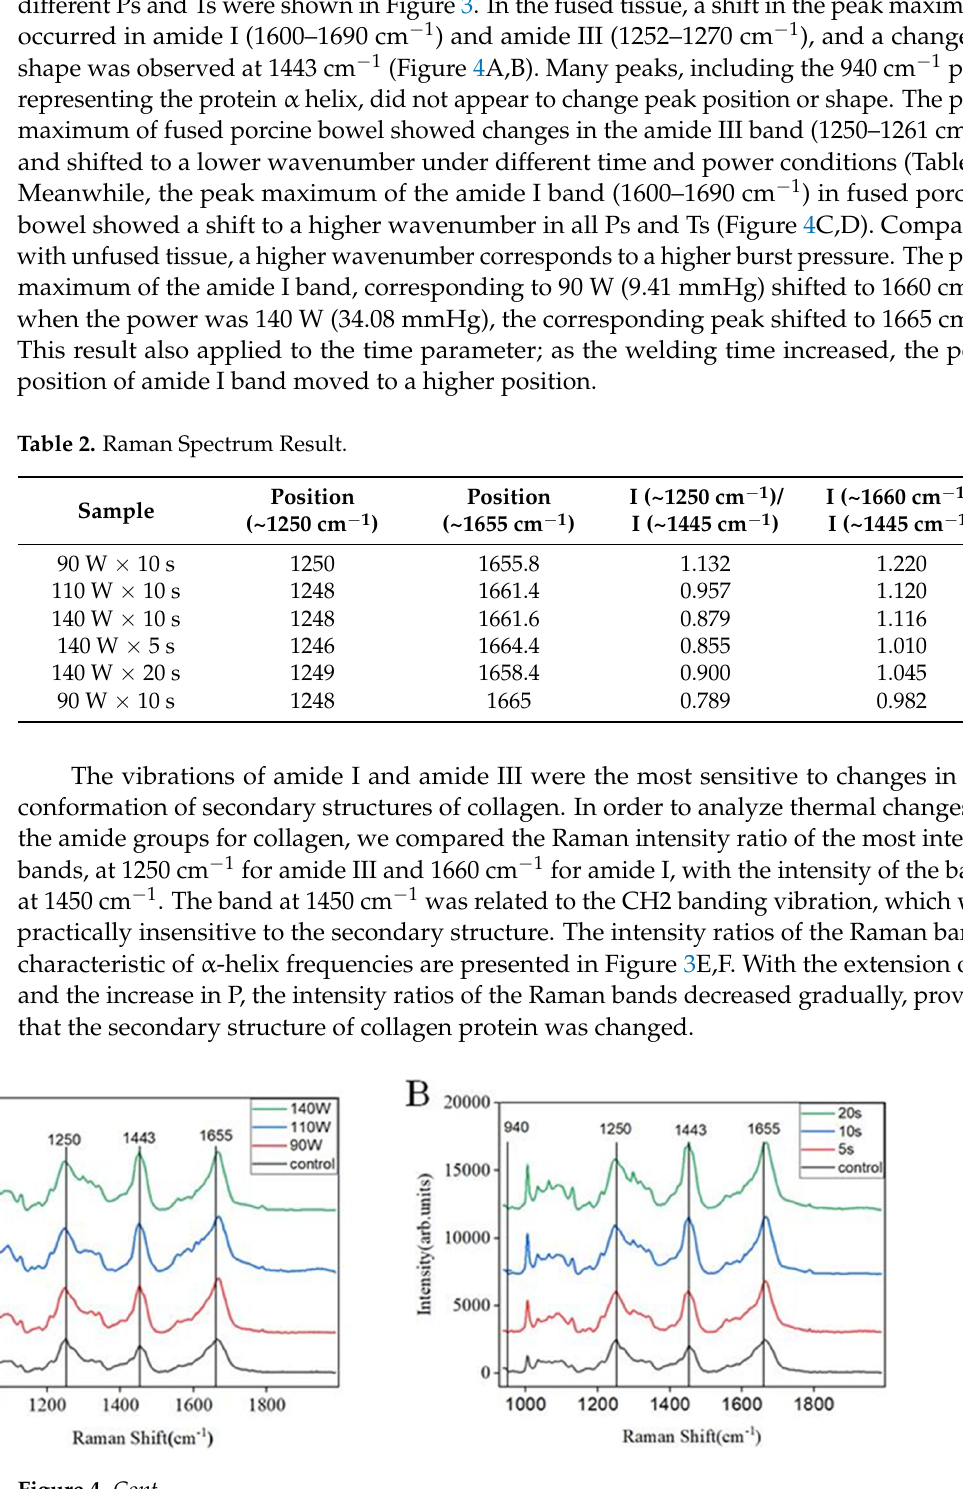
Figure 4. ( A , B ). Mean Raman spectra of control and fused areas mapped in porcine bowel tissue undergoing different Ps and Ts. Raman Shifts of 940 cm − 1 , 1250 cm − 1 , 1443 cm − 1 and 1655 cm − 1 are highlighted corresponding to the protein alpha helix, amide Ⅲ , CH2 wag, and amide Ⅰ . ( C , D ). Peak maximum Raman shift (cm − 1 ) location of amide I in small intestine tissue comparing fused tissue and control tissue. Samples were fused with different Ps and Ts. The corresponding average burst pressure is in parentheses, * p -value<0.05. ( E , F ). Raman intensity ratios of amide I( ~ 1660 cm − 1 )/I ( ~ 1445 cm − 1 ) and amide Ⅲ I( ~ 1250 cm − 1 )/I( ~ 1445 cm − 1 ) in the small intestine’s fused area, undergoing different Ps and Ts.